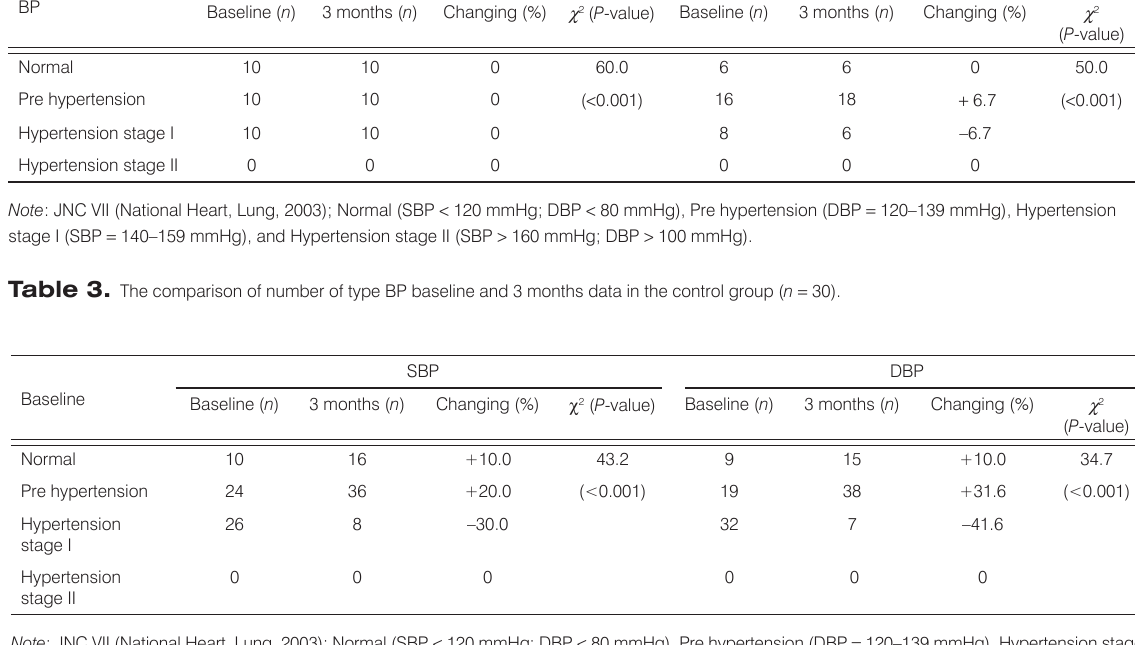
as shown in Table 4. There was increased number of normal and pre hypertension for SBP and DBP (10% vs. 10%; and 20% vs. 31.6%), and reduced